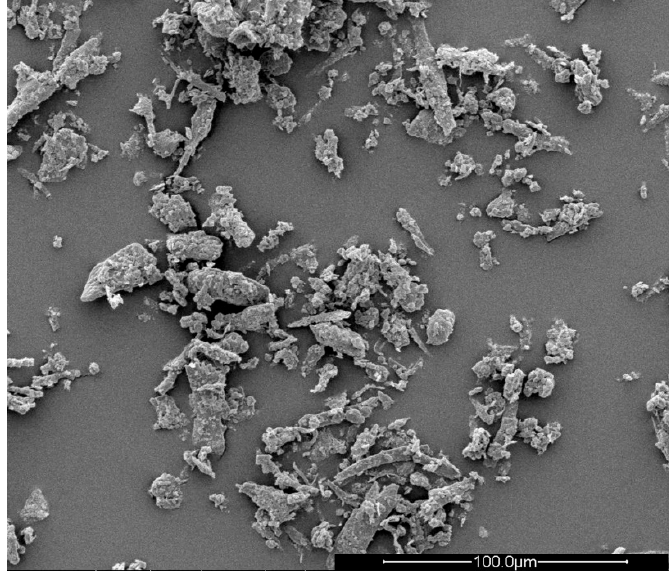
Figure 1. Scanning electron microscopy (SEM) image of keratin